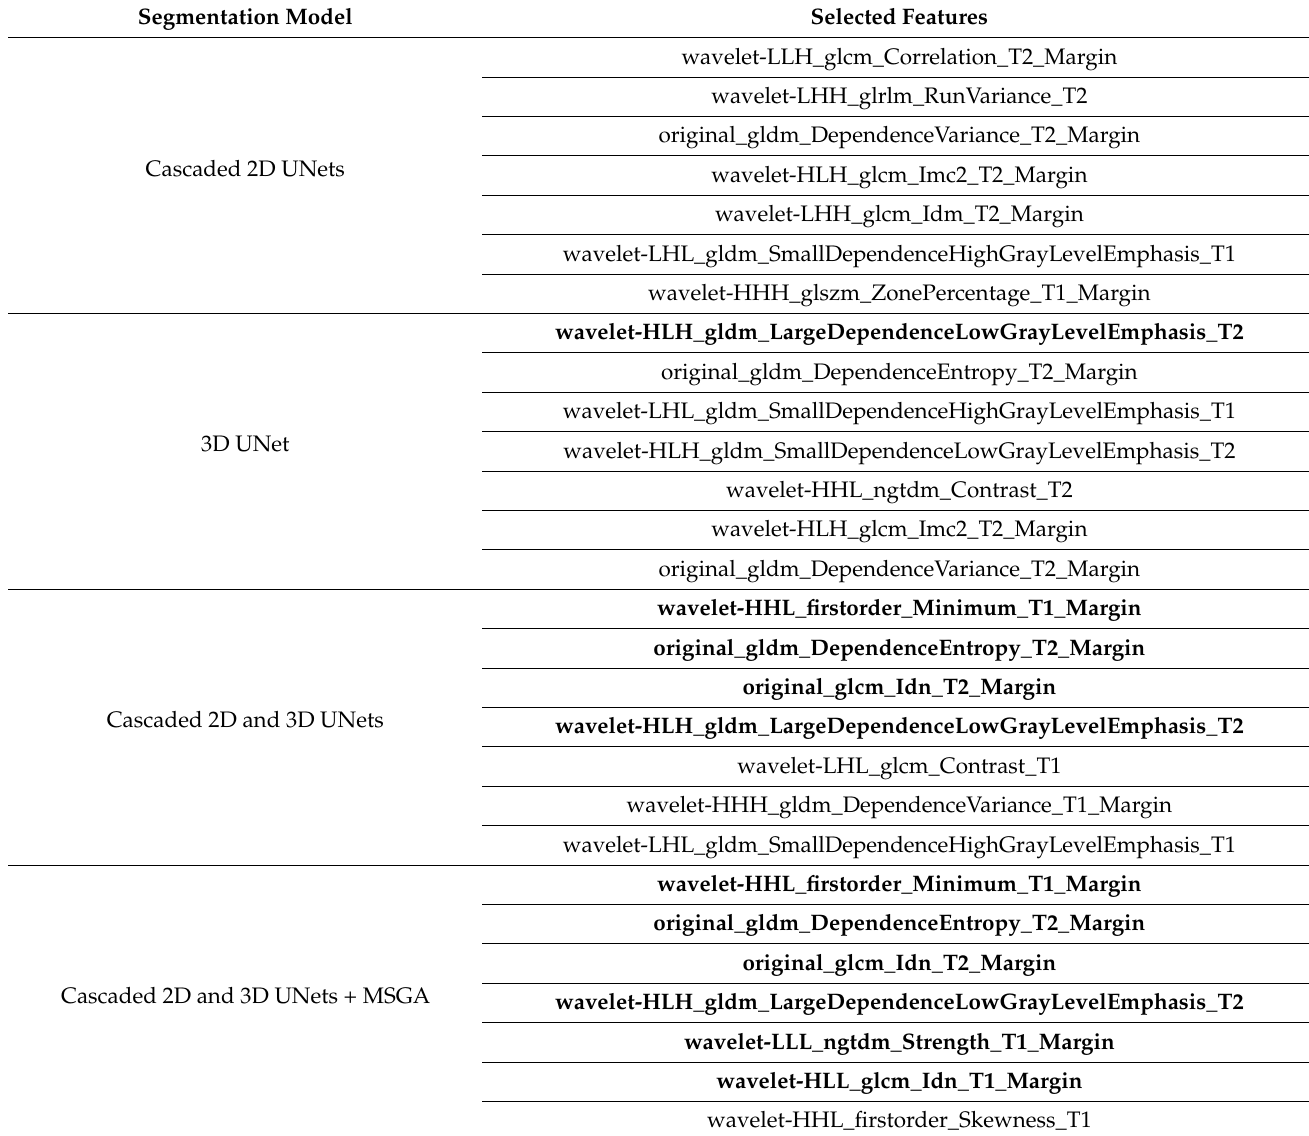
Table 2. List of the top seven selected features using the mRMR feature selection method for different segmentation models. Bold features are the shared ones with those obtained using the ground-truth segmentation